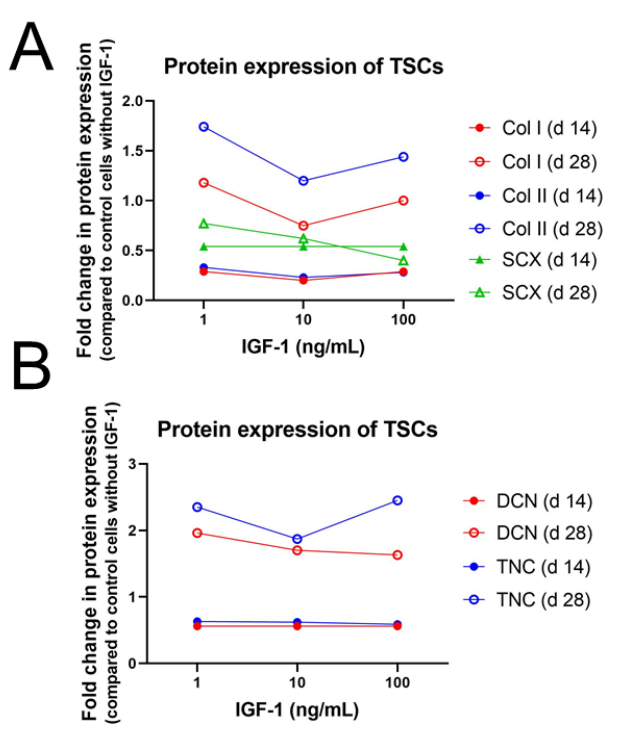
Figure 3. Impact of IGF-1 concentration on the protein expression of collagen I and II (col I and col II) and Scleraxis (SCX) ( A ) as well as Decorin (DCN) and Tenascin-C (TNC) after 14 or 28 days in rat tendon stem cell culture (TSC) in basal TSC medium [78] ( B ).